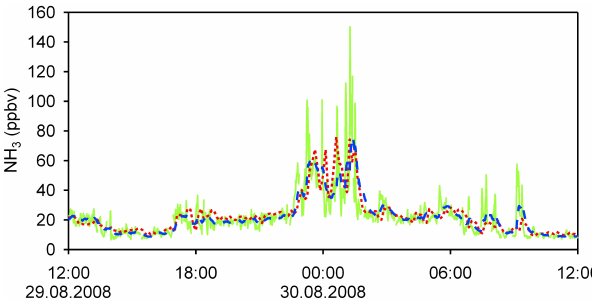
Fig. 6. Comparison of the time-series of the AMANDA (red/dotted) and the c-QCLAS (green) for a 24h period on 29 to 30 August 2008. The c-QCLAS smoothed concentration c 0 (t) (blue/dashed) was cal- culated with f =0.08, selected by eye as a fit to the AMANDA